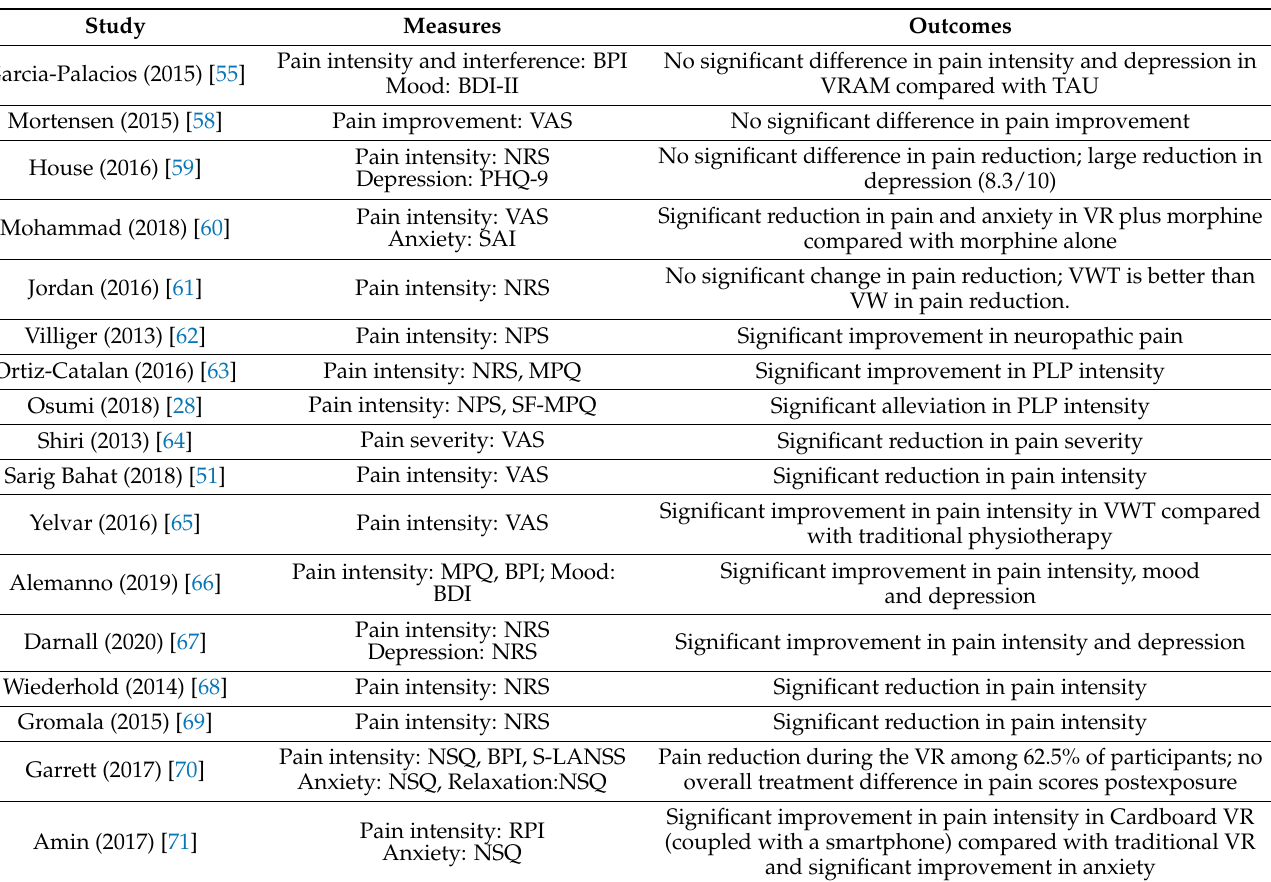
Table 5. Details on pain intensity, anxiety, depression and mood measures and